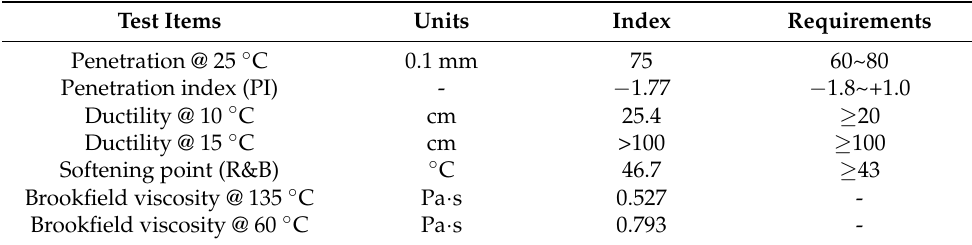
Table 1. Basic performance parameters of AH-70 asphalt binder.